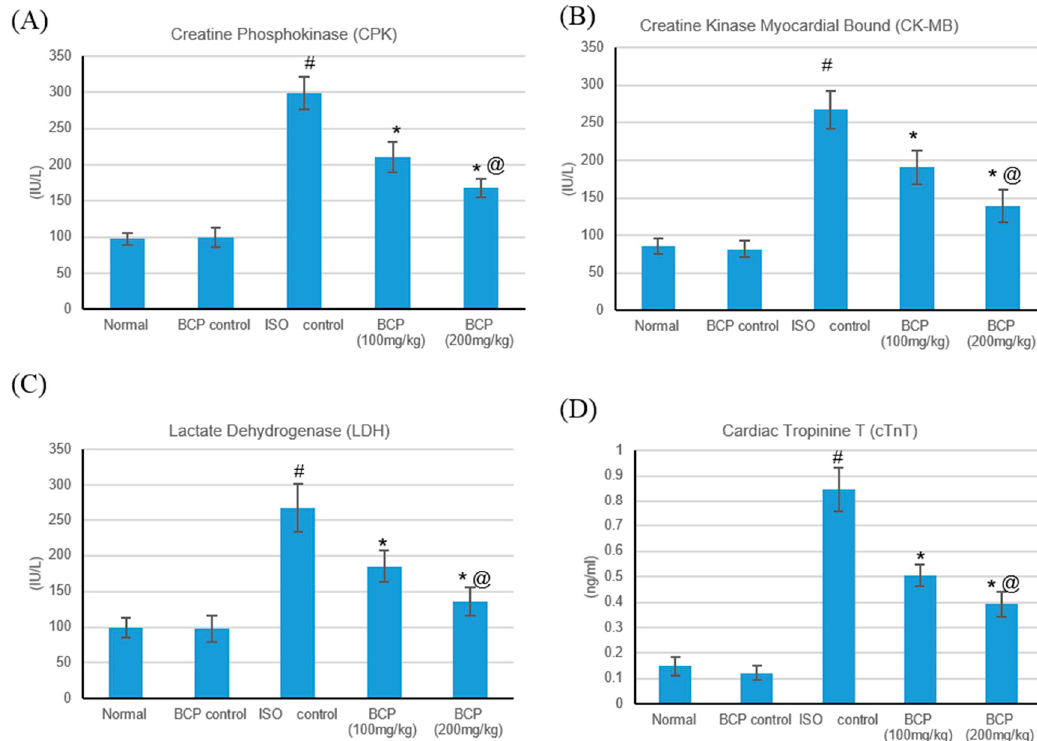
Figure 5. Effects of β -caryophyllene treatment (100, 200 mg/kg) for 21 days on cardiac marker enzymes in ISO-induced myocardial infarction: ( A ) CPK, ( B ) CK-MB, ( C ) LDH, and ( D ) cTnT. All values were expressed as mean ± SD ( n = 6). ISO: isoproterenol; BCP: β -Caryophyllene; CPK: Creatine Phosphokinase; CK-MB: Creatine Kinase-Myocardial Bound; LDH: Lactate dehydrogenase and cTnT: Cardiac Troponin T. # indicates statistically significant from normal group, * indicates statistically significant from isoproterenol group, @ indicates statistically significant from β -caryophyllene (100 mg/kg) group ( p < 0.05) using one-way ANOVA followed by Tukey’s test as a post-hoc analysis.